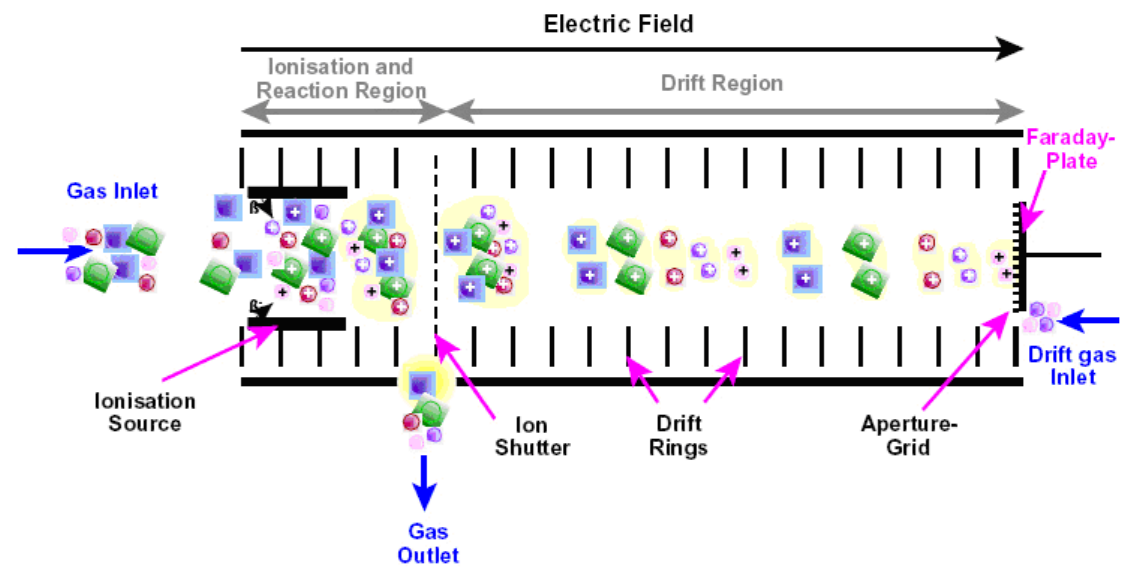
Figure 1: Schematic overview of the working principle of an ion mobility